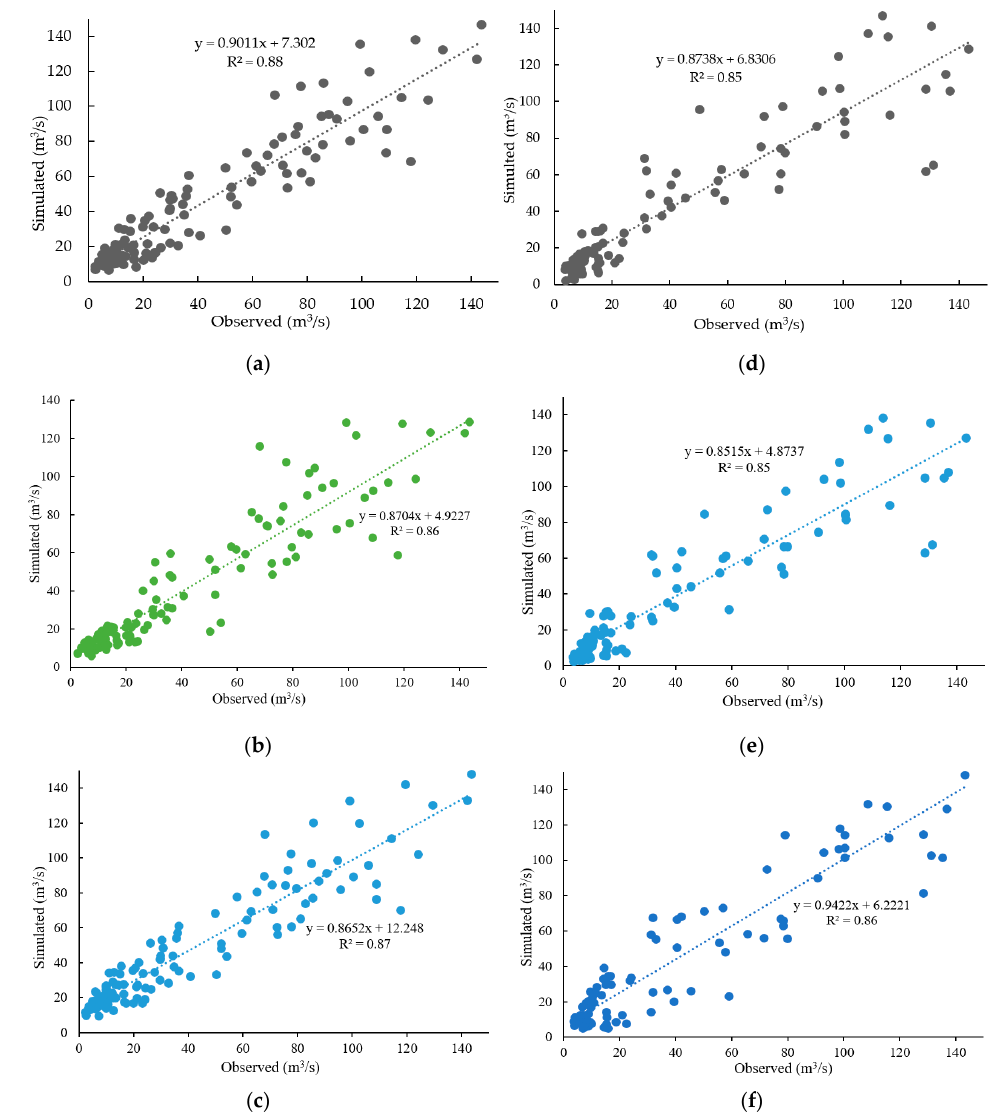
Figure 5. Scatter plot of measured and simulated flow during calibration ( a – c ); validation ( d – f ) for LULC-2000, -2010, and -2020 simulations, respectively.